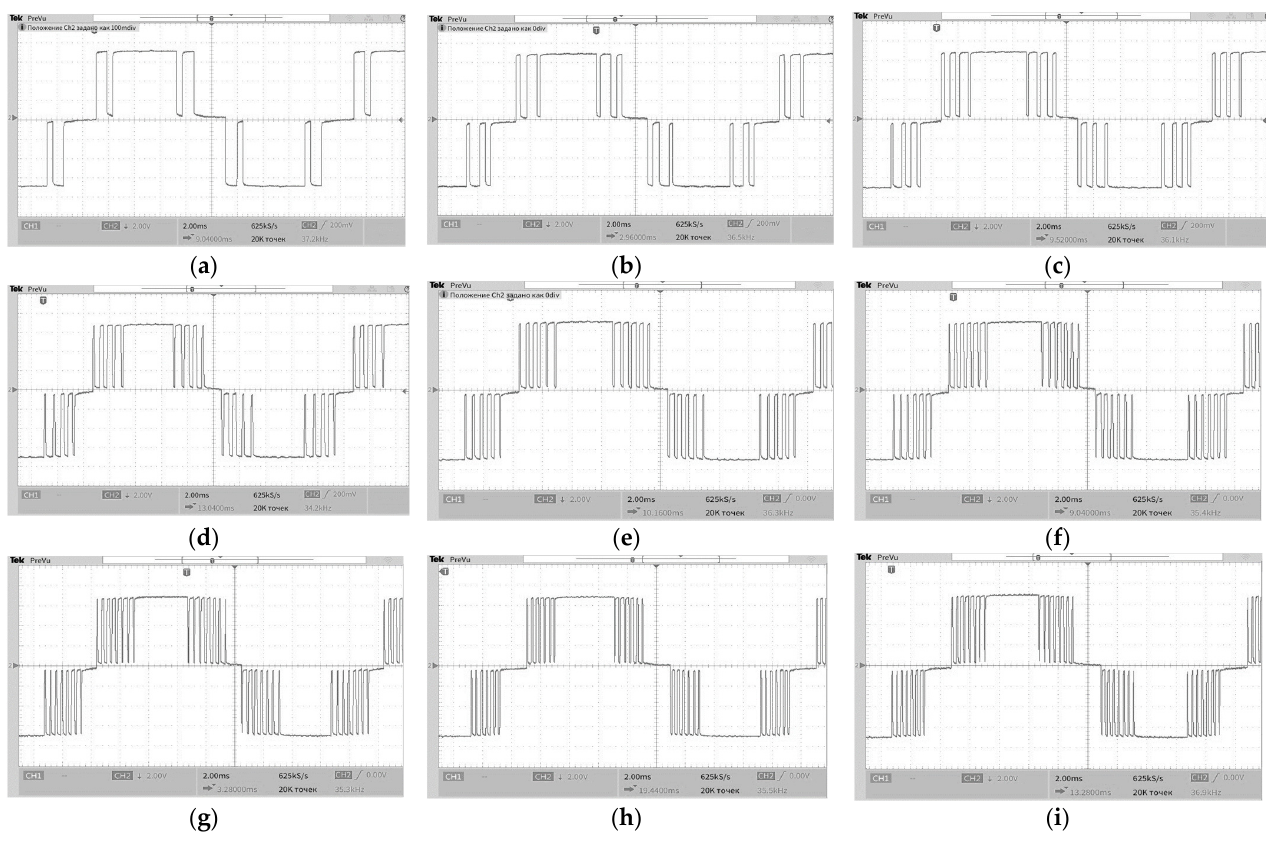
Figure 7. PPWM waveforms of the AFE converter: ( a ) SHE3; ( b ) SHE5; ( c ) SHE7; ( d ) SHE9; ( e ) SHE11; ( f ) SHE13; ( g ) SHE15; ( h ) SHM13; ( i ) SHM15.